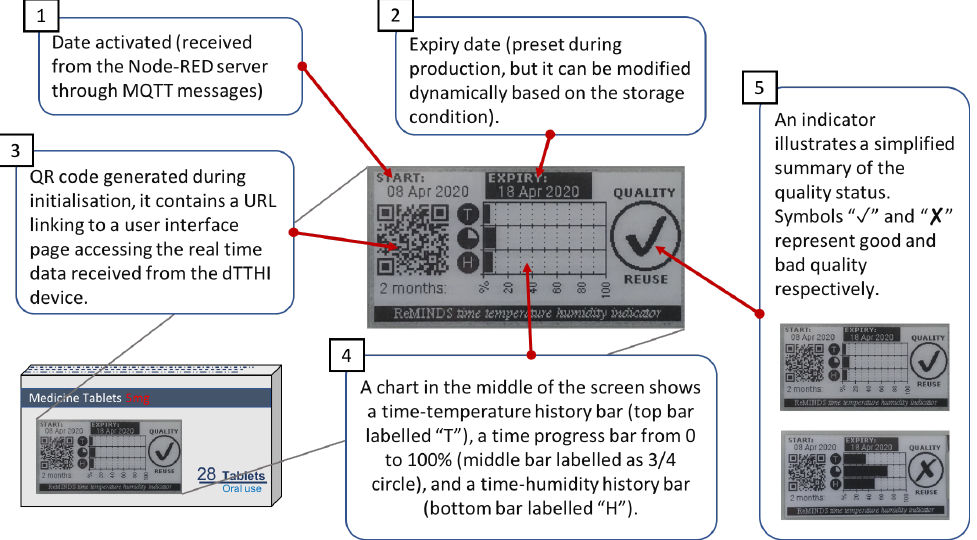
Figure 5. On-package display showing the real time quality status of the packaged